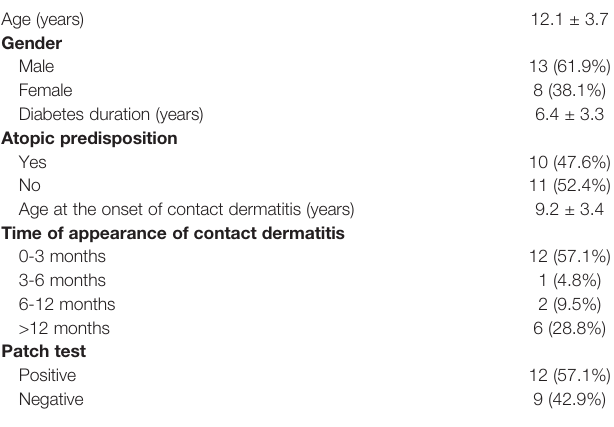
TABLE 1 | Anamnestic and clinical data of our study cohort.